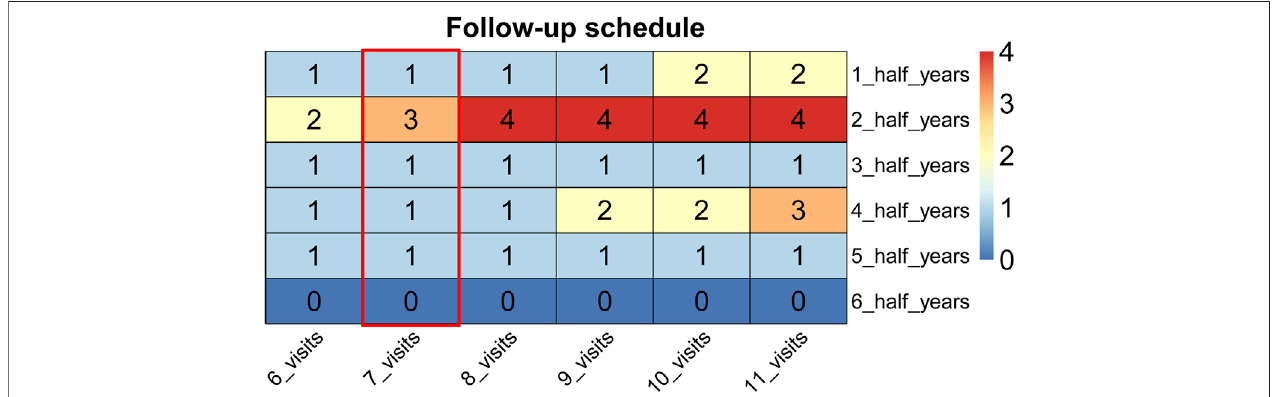
FIGURE 3 | The supervision arrangements ranging from 6 to 11 follow-up times. The follow-up schedules of seven times are highlighted in the red box.